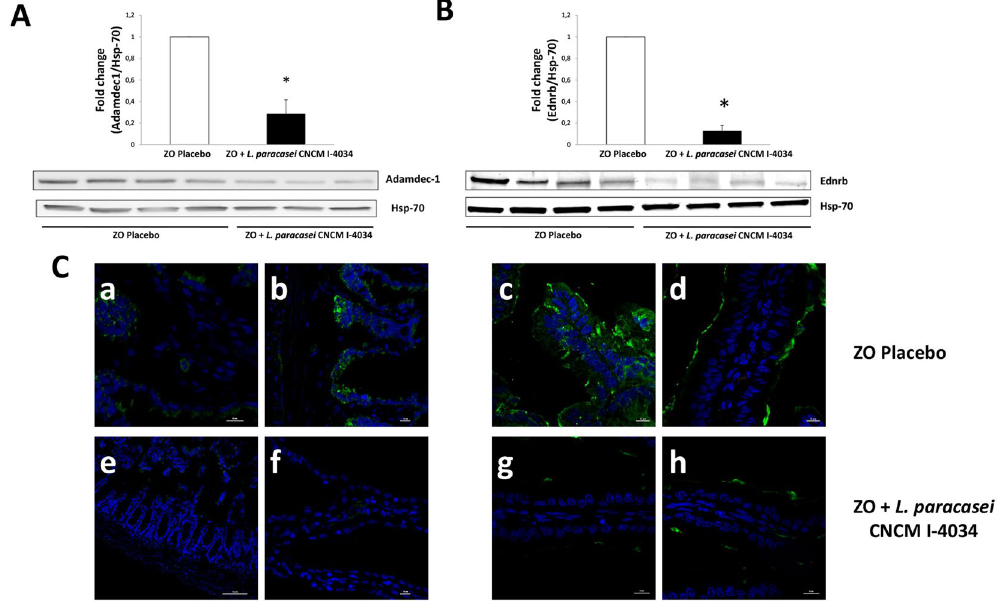
Figure 3. Immunofluorescence and western blot analysis of Adamdec1 and Ednrb proteins from Zucker- Lepr fa / fa rats fed the placebo compared with Zucker-Lepr fa / fa rats fed L . paracasei CNCM I-4034. In panels A and B, top graphs include 7–8 rats per group, and the lower parts show a representative crop blot. Hsp-70 was used as a loading control. * p < 0.05. In panel C, micrographs a,b (ZO placebo), and e,f (ZO + L . paracasei CNCM I-4034) show results for Adamdec1, and micrographs c,d (ZO placebo), and g,h (ZO + L . paracasei CNCM I-4034) show results for Ednrb. The green color corresponds to Alexa Fluor 488 dye. ZO, Zucker-Lepr fa / fa rats.